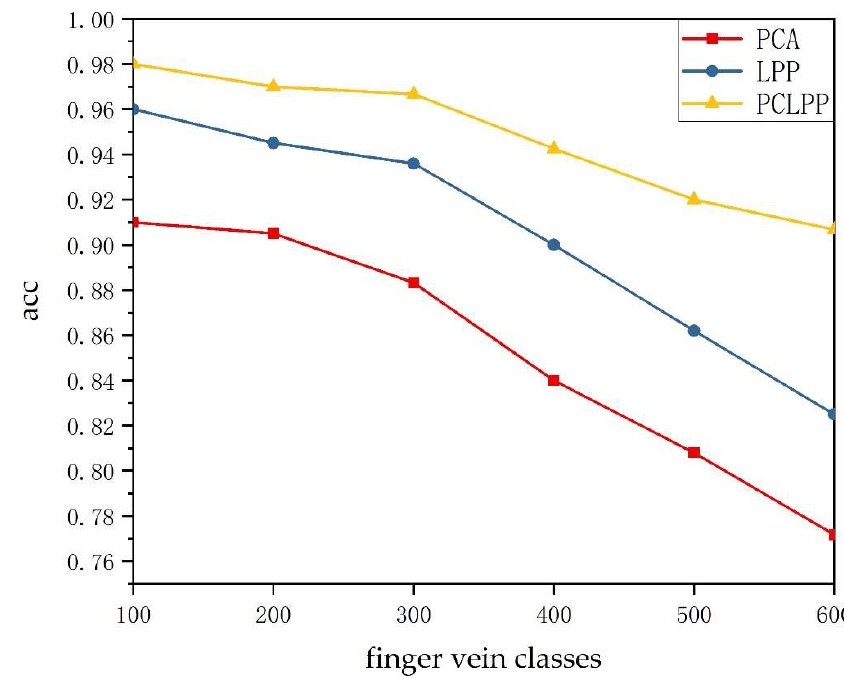
Figure 9. Image recognition rates for PCA, LPP, and PCLPP after adding Gaussian noise.